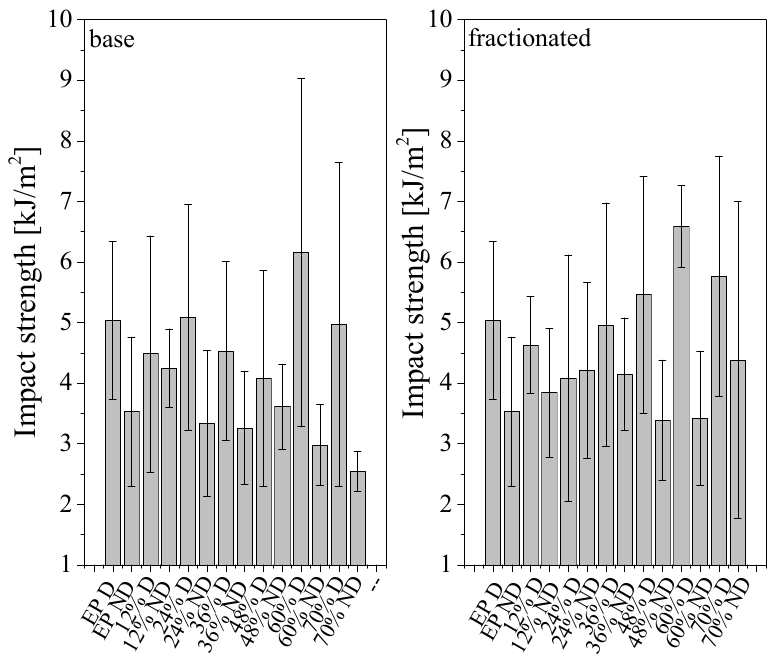
Figure 15. Impact strength for degassed and non-degassed composites containing base and fractionated diatoms.